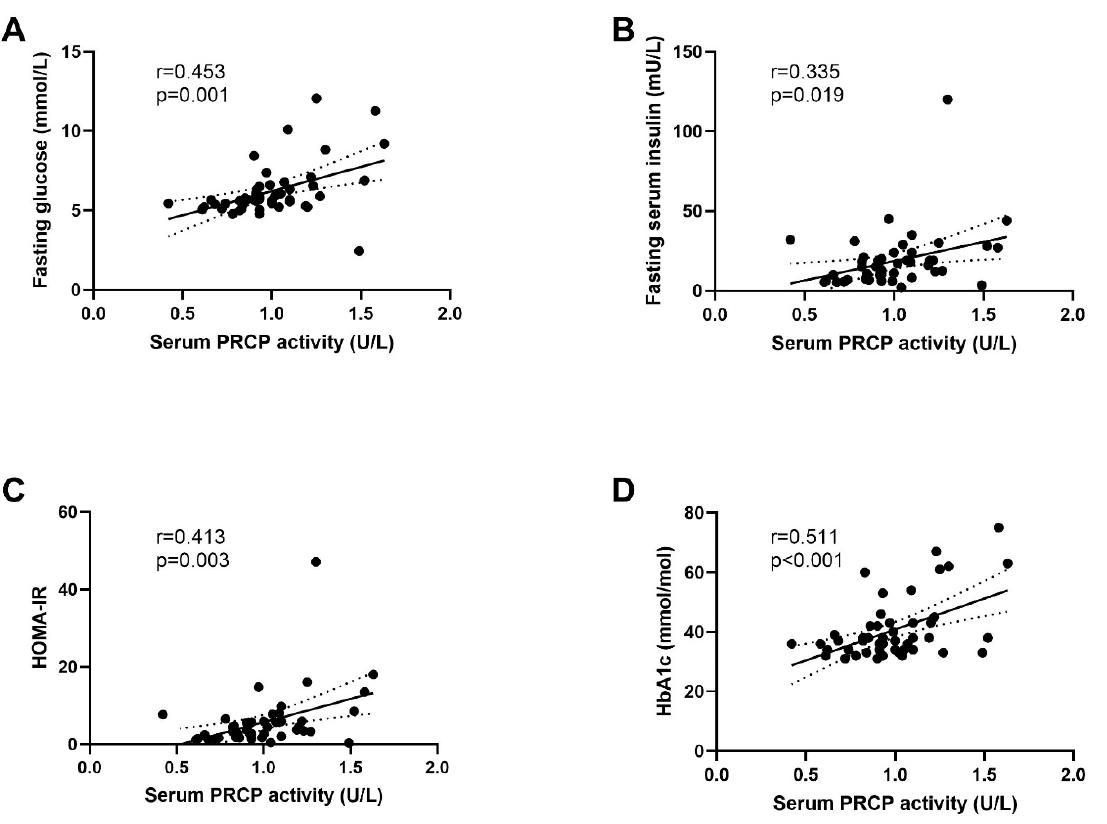
Figure 5. Correlation between serum PRCP activity and fasting glucose ( A ), fasting serum insulin ( B ), HOMA-IR ( C ) and HbA1c ( D ). Linear regression line is shown with 95% confidence interval. Circles: individual values; solid lines: Linear regression line; dotted line: 95% confidence interval for the regression line.